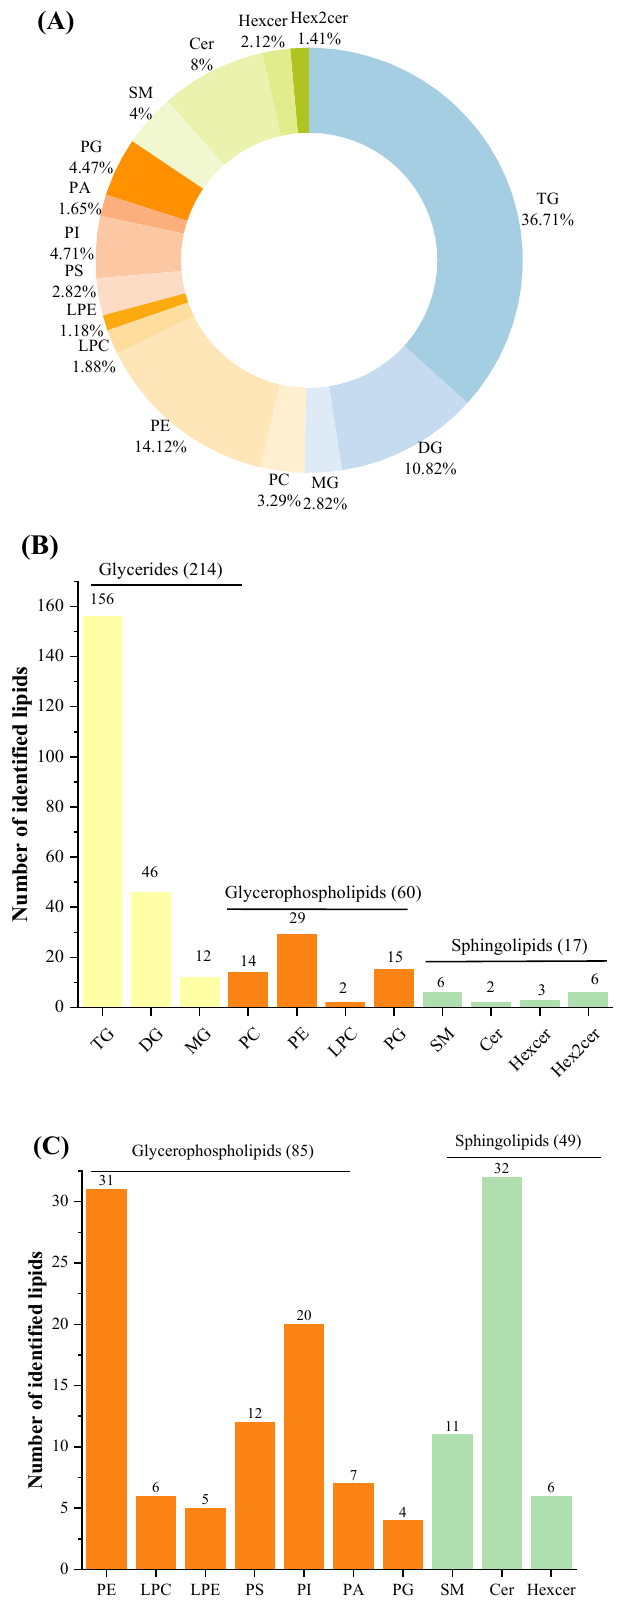
Figure 2. Total identified lipid subclasses in samples: percentages of numbers of lipid subclasses ( A ); numbers of each subclass identified in POS ion mode ( B ); and numbers of each subclass identified in Neg ion mode ( C ). POS, positive; NEG,